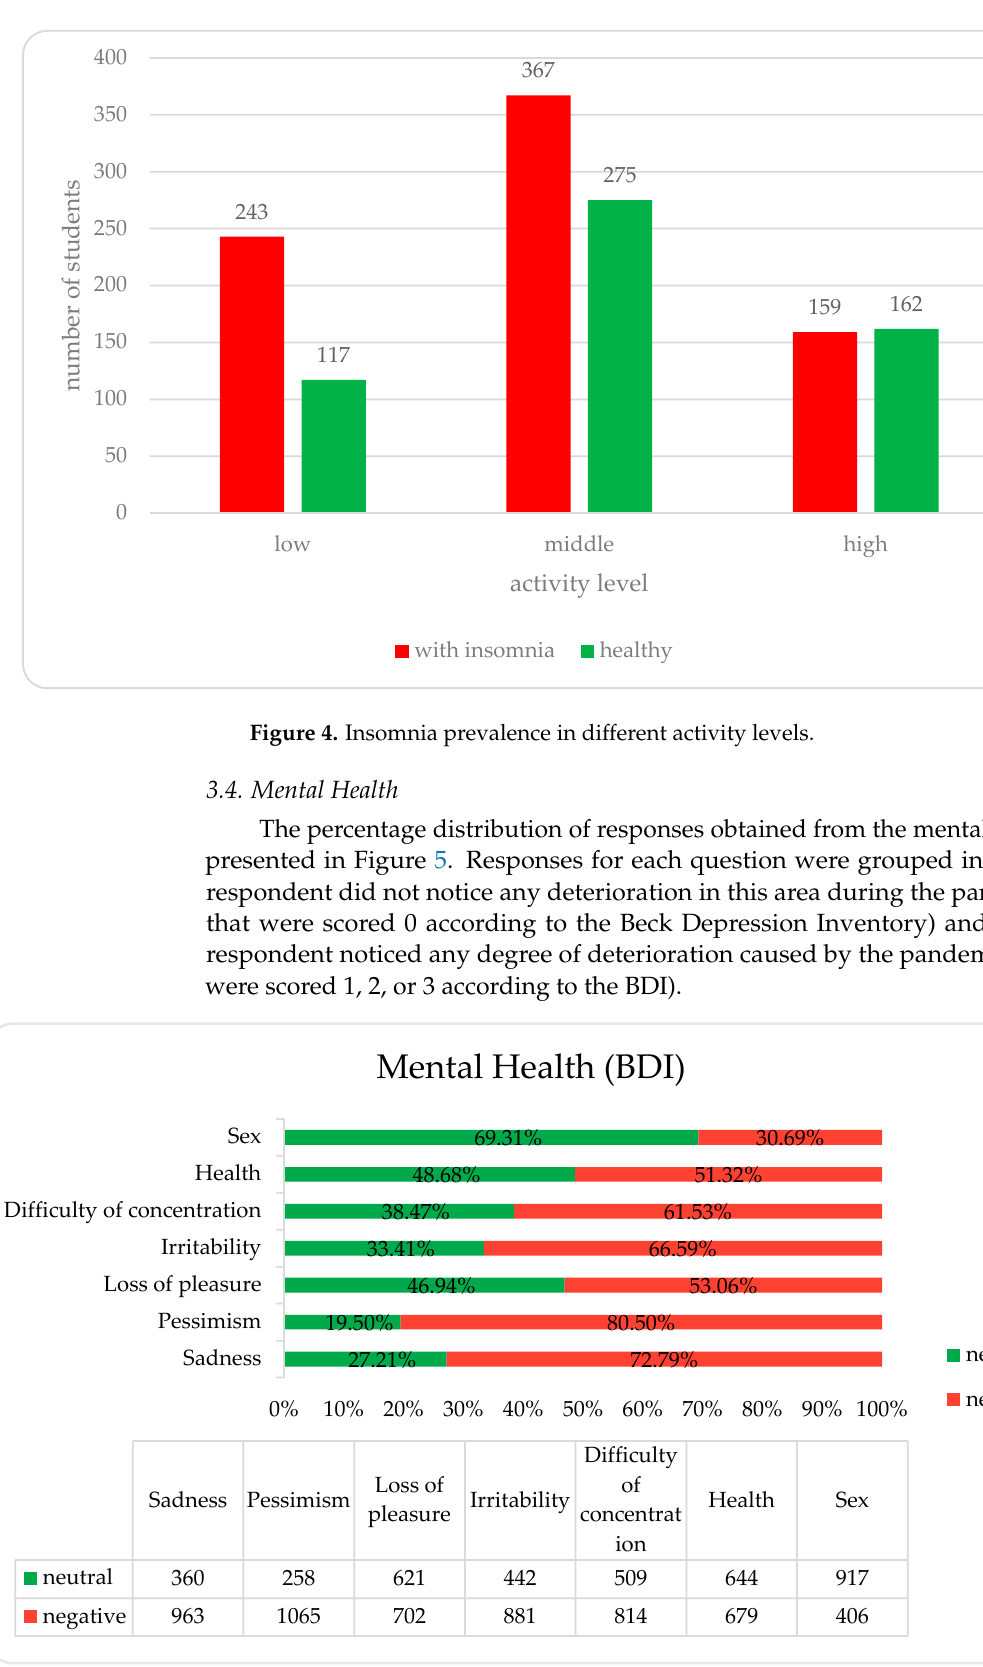
5 of 11 Figure 3. Time spent daily in front of blue-light-emitting devices. 3.3. Sleep-Disturbing Factors The PaLS study results only confirmed that more blue light exposure can worsen one’s sleep quality, leading to insomnia ( p = 0.02543). There were also other factors re- sponsible for the higher insomnia rate. Respondents with insomnia drank higher amounts of coffee drinks per week (mean = 25.031) than respondents without insomnia (mean = 20.287, p = 0.000001). The results showed that students with low and middle activity levels